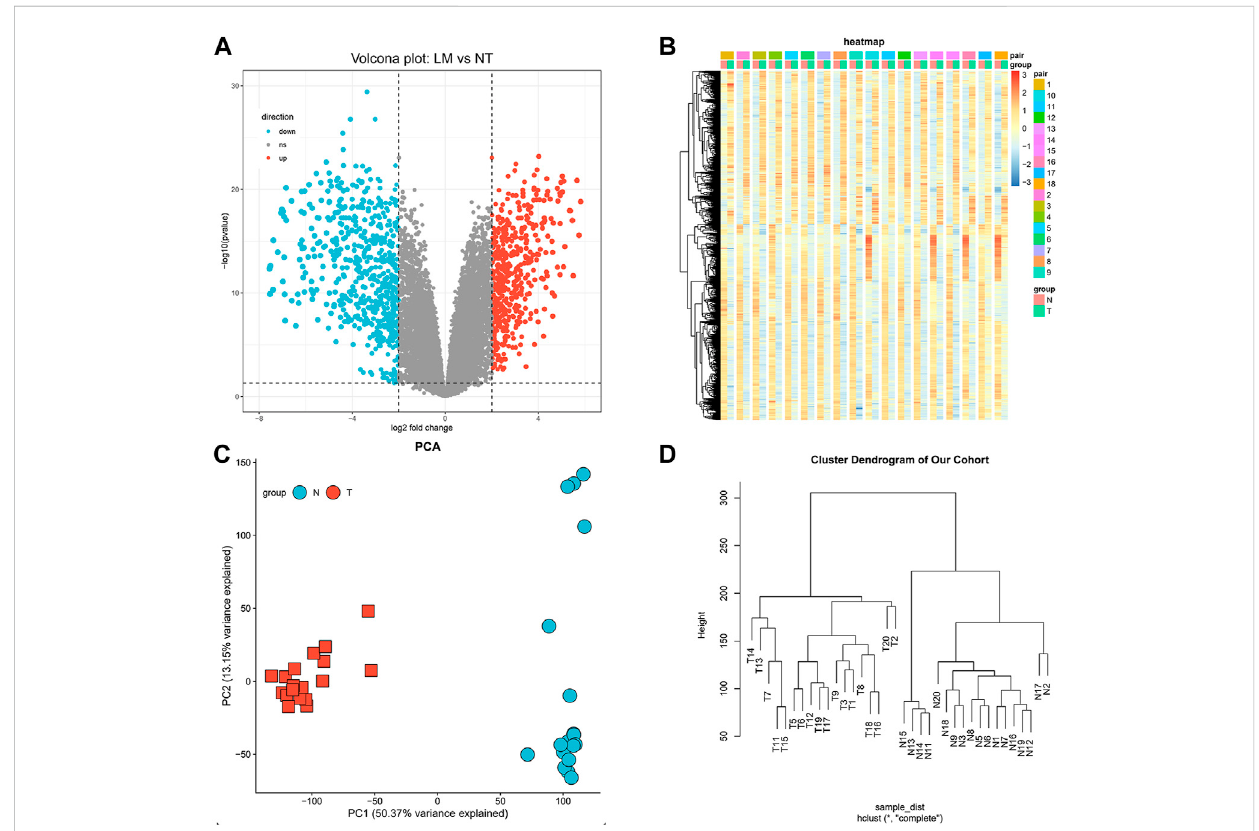
FIGURE 2 Identi fi cationofdifferentiallyexpressedgenes. (A) Volcanomapofdifferentiallyexpressedgenes(Upregulatedgenesinred,downregulatedgenesin blue). (B) Hierarchical clustering heatmap ofDEGsscreenedon thebasis ofFC > 2.0 andacorrected p -value < 0.05. (C) ShowsPCAresults ofourcohort. (D) Visual hierarchical cluster